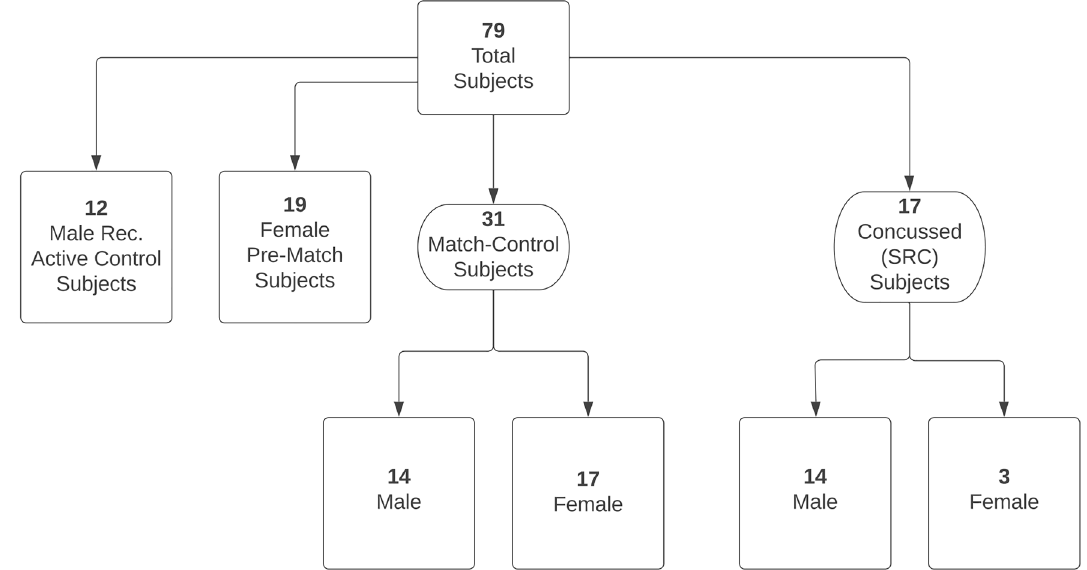
Figure 1. Schematic explanation of subject groups. Rec. recreationally, SRC sport related concussion.